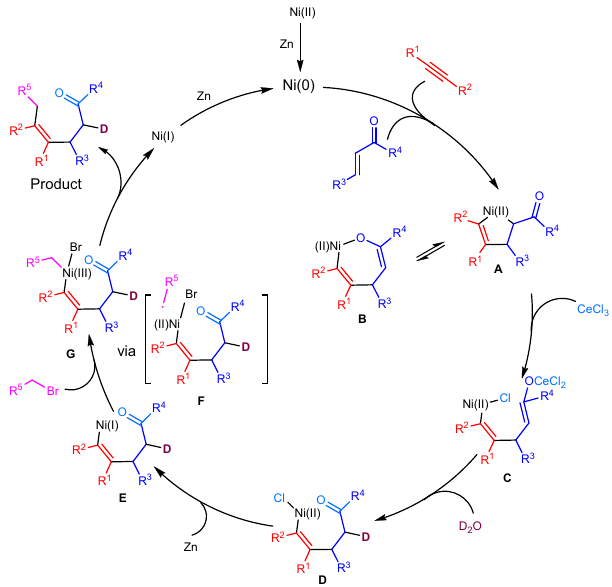
Fig. 7 Proposed reaction mechanism. Speci fi cally, A , B : Ni (II) intermediates of cyclometallation of alkynes with enones; C , D : Ni (II) intermediates after Ni-O bond dissociation; E : Ni (I) intermediate reduced by Zn; F : transition state for single-electron reduction of Ni (I) with alkyl bromides; G : Ni (III) intermediate of oxidative addition to alkyl